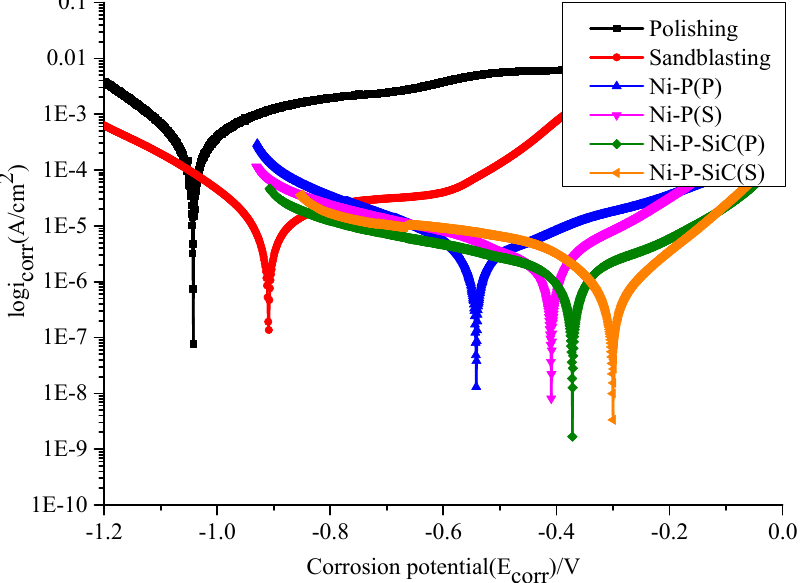
Figure 10. Potential polarization curves of coatings prepared by scanning electrodeposition on 45 steel substrates with different pretreatment processes.